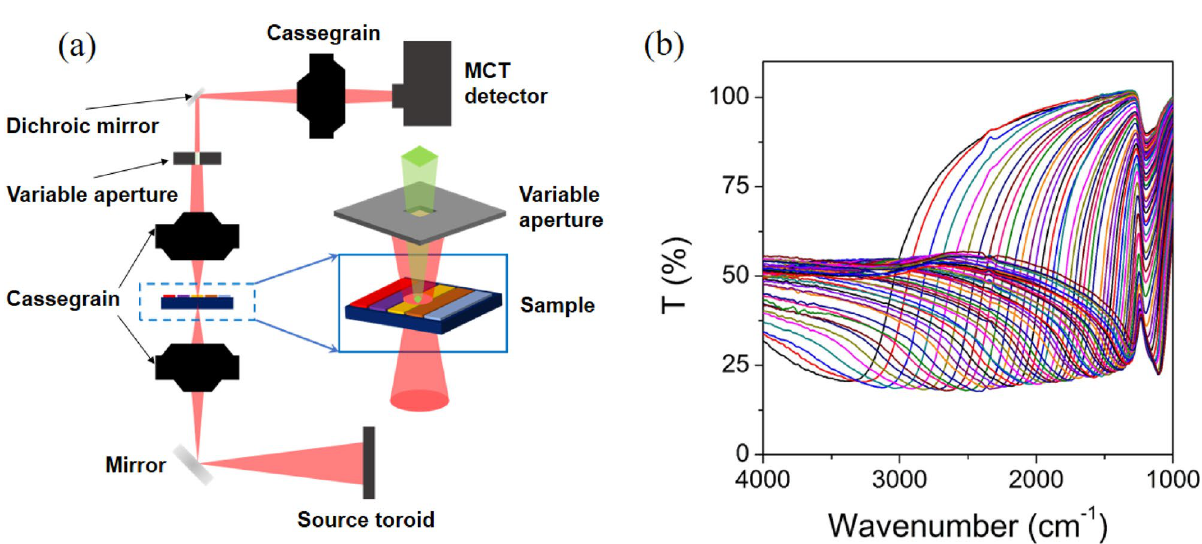
Figure 5. ( a ) A schematic diagram of FTIR microscope for the measurement of IR transmittance and ( b ) measured transmission spectra of Al nanodiscs array